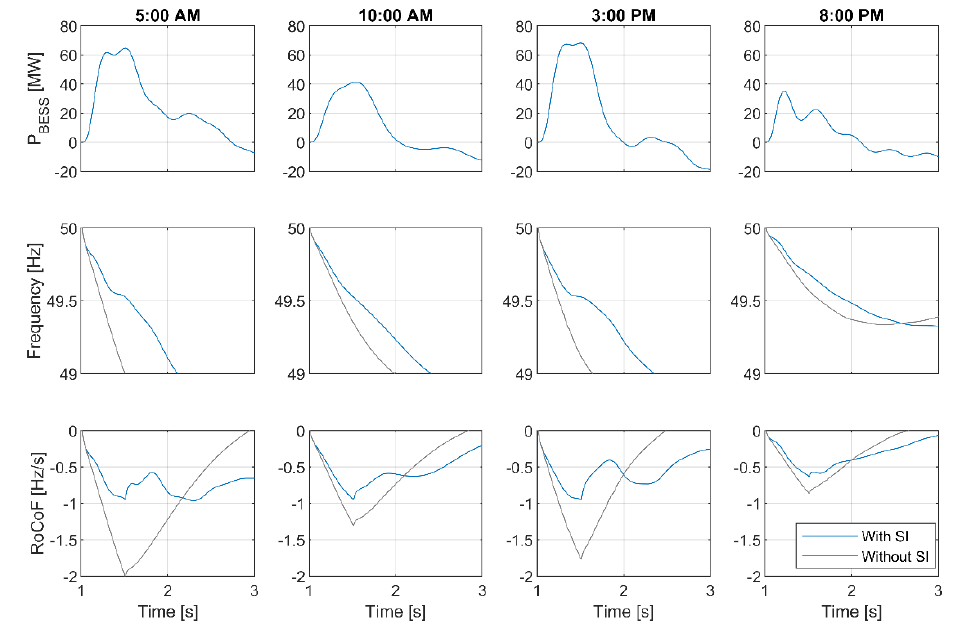
Figure 9. Reponses to generation trip of the system equipped with SI (blue) and without SI (grey) for four different instants during the planning period.